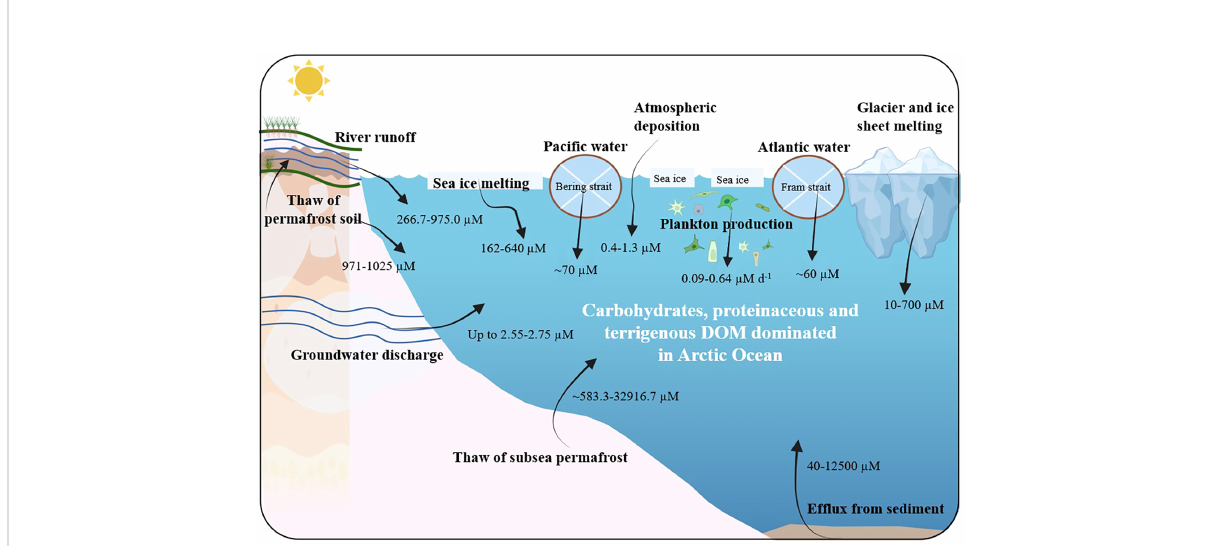
FIGURE 2 Sources of DOM imports into the Arctic Ocean. Concentration of DOM was derived the previous studies: river discharge (Behnke et al., 2021), Atlantic and Paci fi c water intrusion (Borsheim and Drinkwater, 2014; Jørgensen et al., 2014; Anderson and Amon, 2015), plankton production (Poulton et al., 2016), melted sea ice (Retelletti Brogi et al., 2018), thawed permafrost soil (Ward and Cory, 2015), melted ice sheets and glaciers (Bhatia et al., 2010; Bhatia et al., 2013; Kellerman et al., 2021), thawed subsea permafrost (Overduin et al., 2015; Chen et al., 2021), atmospheric deposition (Osterholz et al., 2014; Nakane et al., 2017; Fang et al., 2021), groundwater discharge (Connolly et al., 2020), ef fl ux from Arctic sediment (Chen et al., 2016; Rossel et al., 2016; Rossel et al., 2020). Carbohydrates (i.e., glucose), proteinaceous (i.e., amino acid and protein- like components), and terrigenous characteristics (i.e., humic-like components) of DOM are predominant in surface water of Arctic Ocean as a result of increasing DOM input due to warming